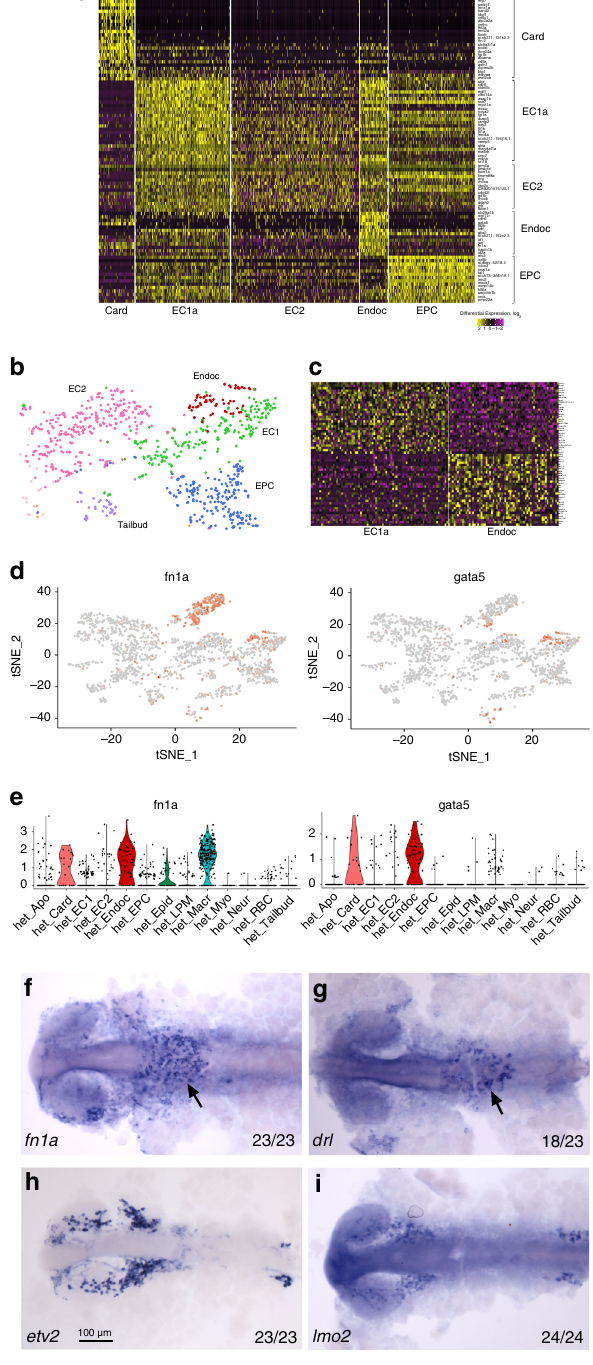
Double heterozygous etv2 ci32Gt/ci33 embryos displayed a signi fi cant increase in GFP + myocytes compared to etv2 ci32Gt + / − embryos (Fig. 3l – n, Supplementary Fig. 11e – h). In addition, GFP expres- sion in skeletal muscle cells was also observed in etv2 y11 − / − mutant embryos crossed into the previously established Tg(-2.3 etv2:GFP) reporter line but not in wild-type Tg(-2.3 etv2:GFP) 14,32 embryos (Fig. 3o). Collectively, these results argue that etv2- expressing progenitors differentiate as skeletal muscle in the absence of Etv2 function.